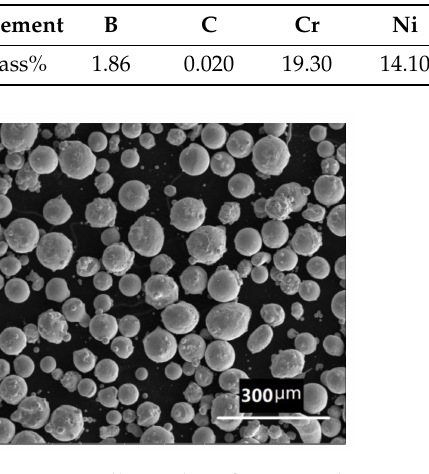
Figure 1. Metallographic of BSS